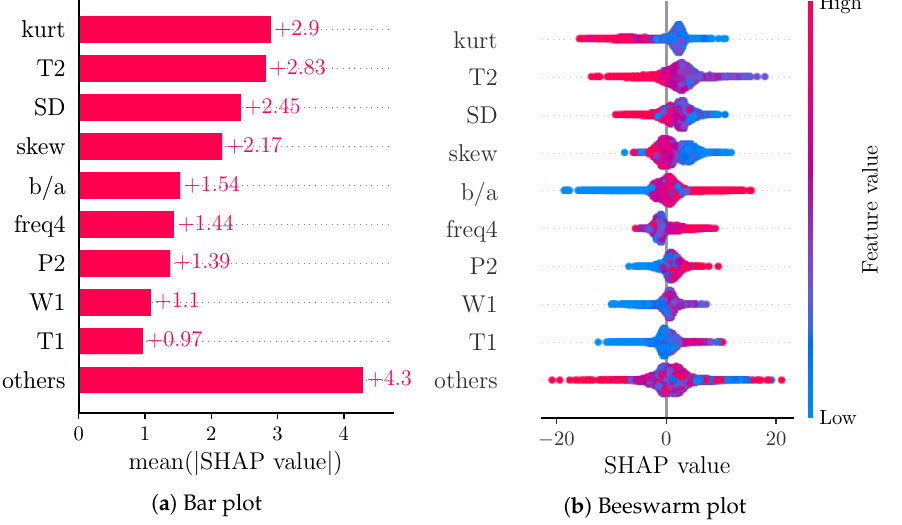
Figure 8. Bar plot of mean absolute SHAP values for comparison models. Shows global feature importance (mean absolute for each feature over all given samples).